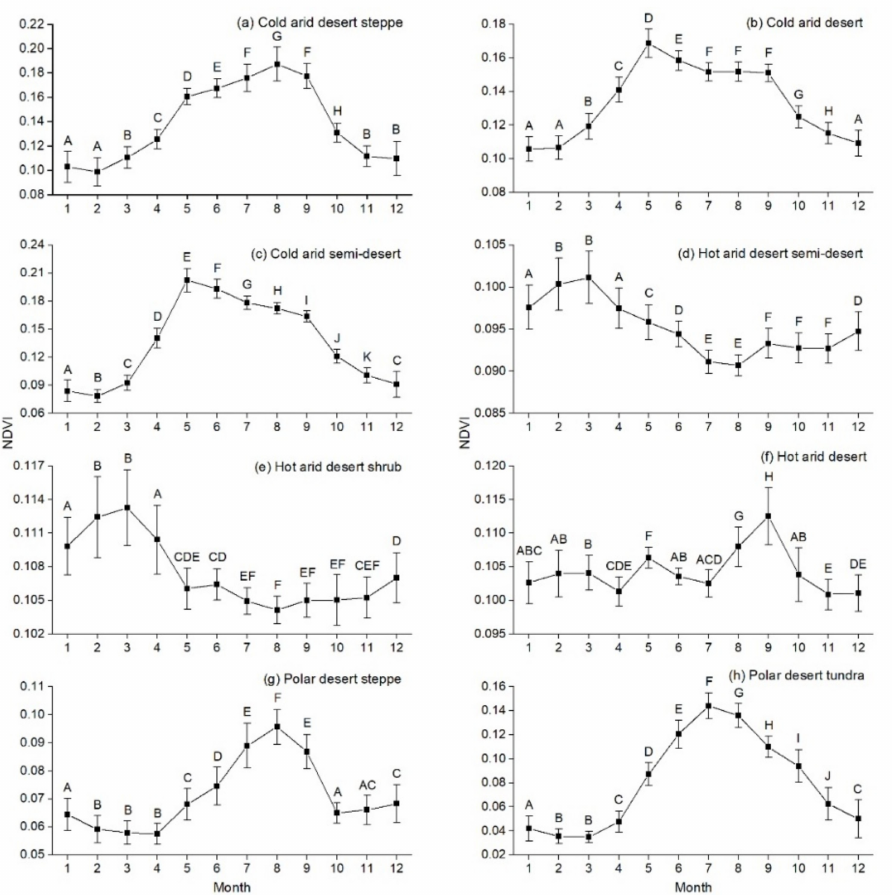
Figure 2. Variation of mean monthly normalized difference vegetation index (NDVI) in different desert areas over the Silk Road Economic Belt between 1982 and 2015. Different uppercase letters indicate significant differences between different months at p < 0.05. ( a – h ) indicate different desert areas,